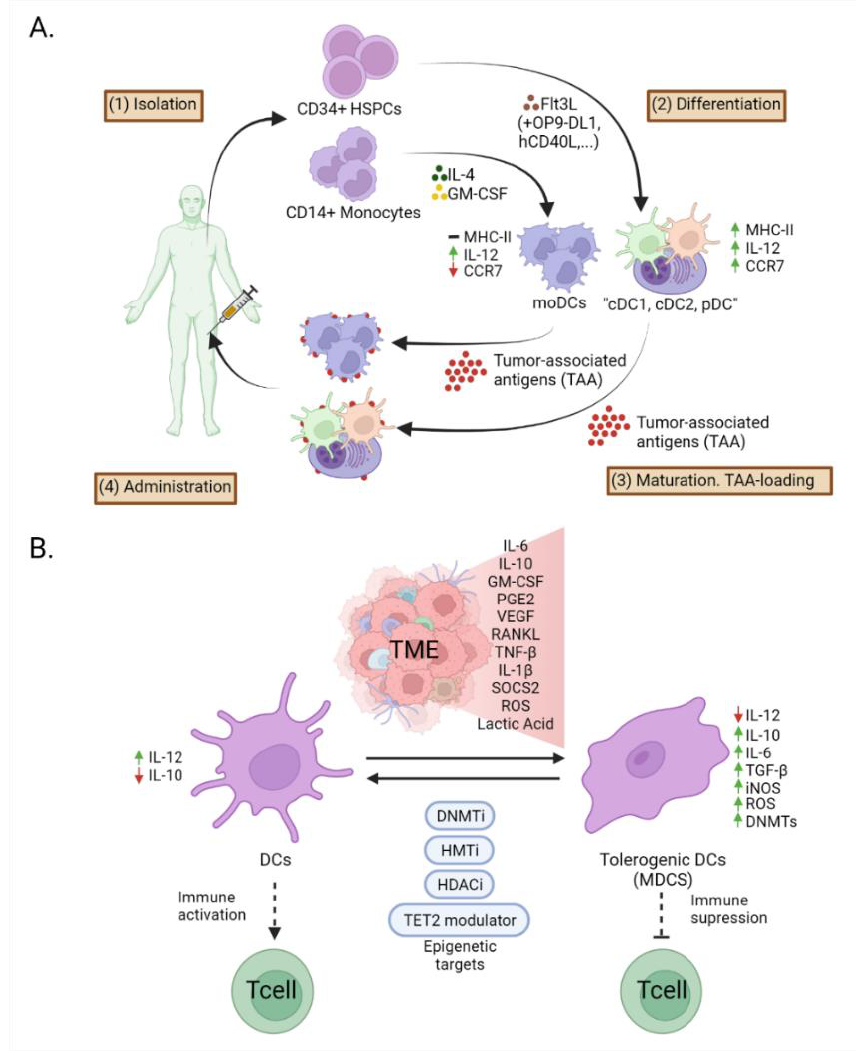
Figure 2. ( A ). Methods used for DC-based cancer vaccines. Black arrows indicate conventional man- ufacturing steps. CD34+ haematopoetic stem progenitor cells (HSPCs) are isolated from cancer pa-